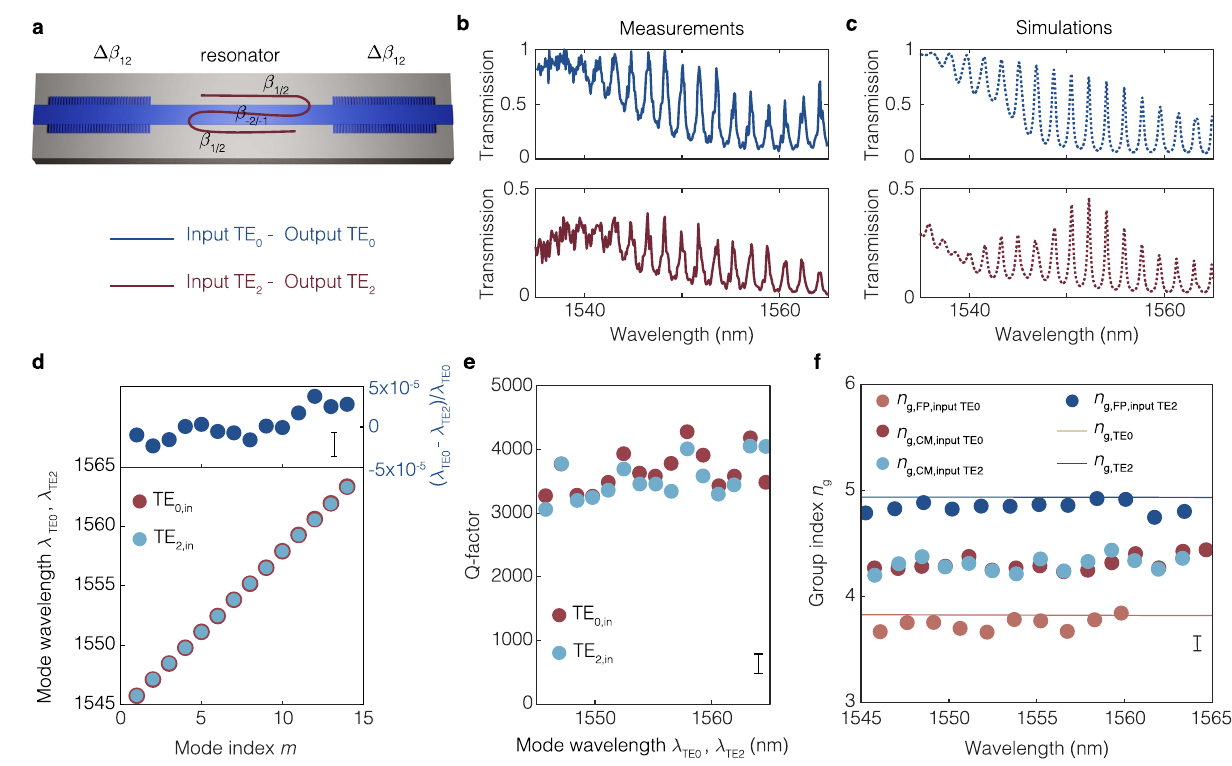
Fig.4|Transmissionspectroscopyofcascaded-moderesonators.a Acascaded- mode resonator, where a re fl ection at both the left and the right Bragg mirror